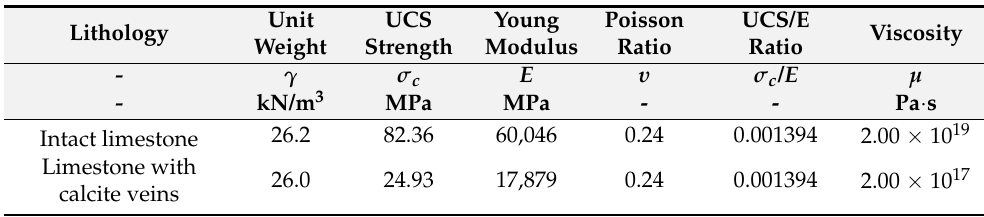
Table 2. Synthesis of physical and mechanical parameters of the intact rock constituting the mass affected by the Luco dei Marsi